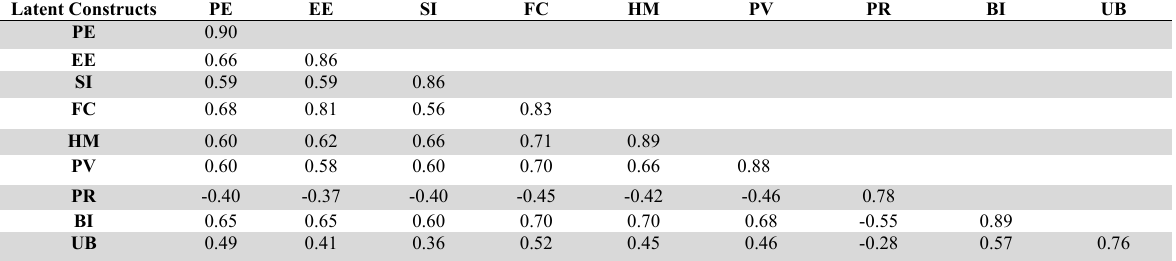
Discriminant validity Latent